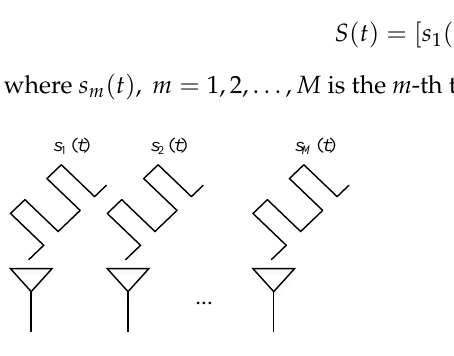
Figure 1. MIMO radar with M transmit signals.